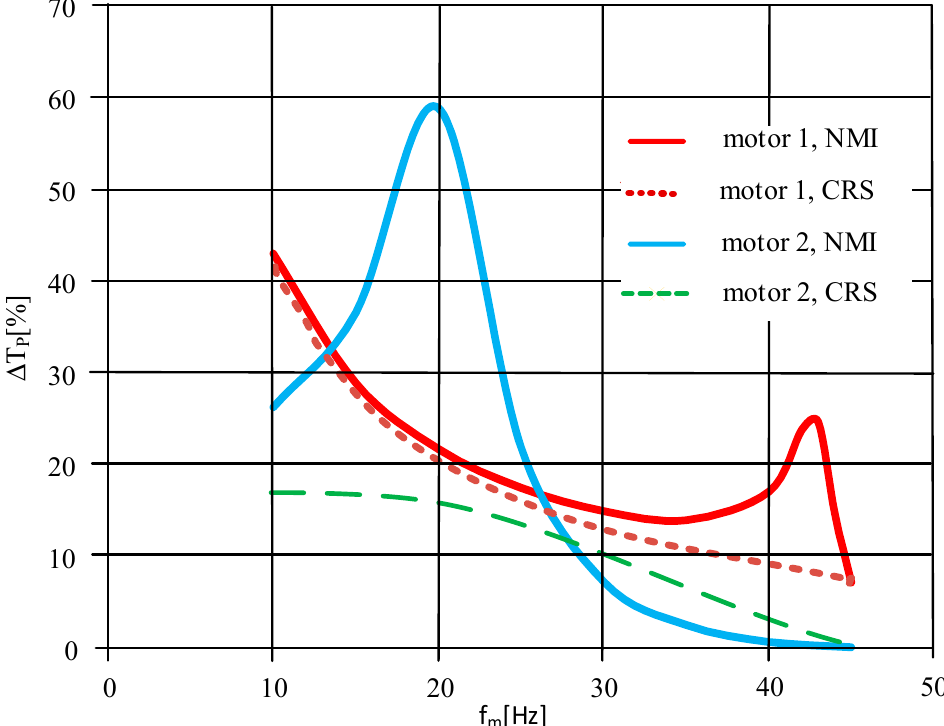
Figure 19. Pulsating torque component ∆ T p of the frequency described with (21), versus the frequency of voltage subharmonics occurring as a single power quality disturbance.